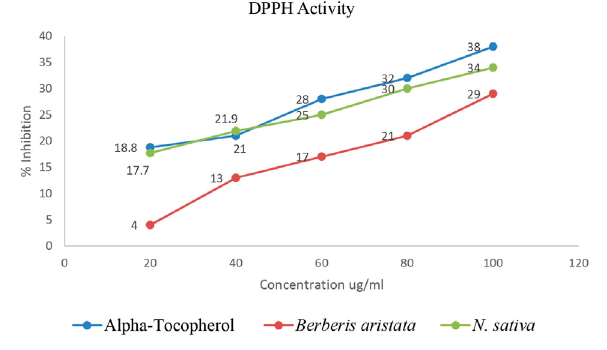
FIGURE 2 | Percentage inhibition vs